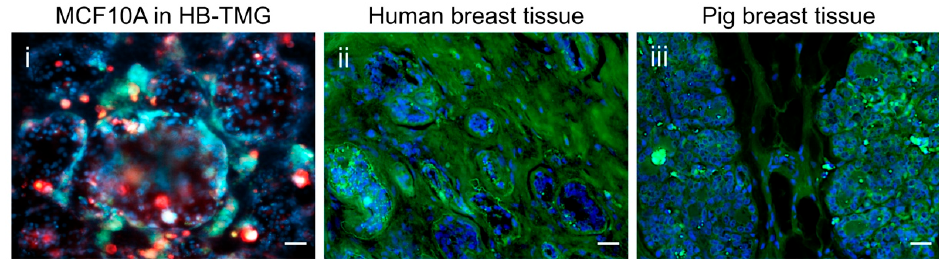
Figure 2. MCF10A cells formed acinar structures in HB-TMG that resemble those acini in human or pig breast tissues. ( i ) IF staining of E-cadherin (green); β 4-integrin (red); nuclei (blue, Hoechst). ( ii and iii ) IF staining of the acinar structures in the cross sections of human or pig breast tissues. Green: collagen staining; blue: nuclei staining with Hoechst. Scale bars, 20 μ m.